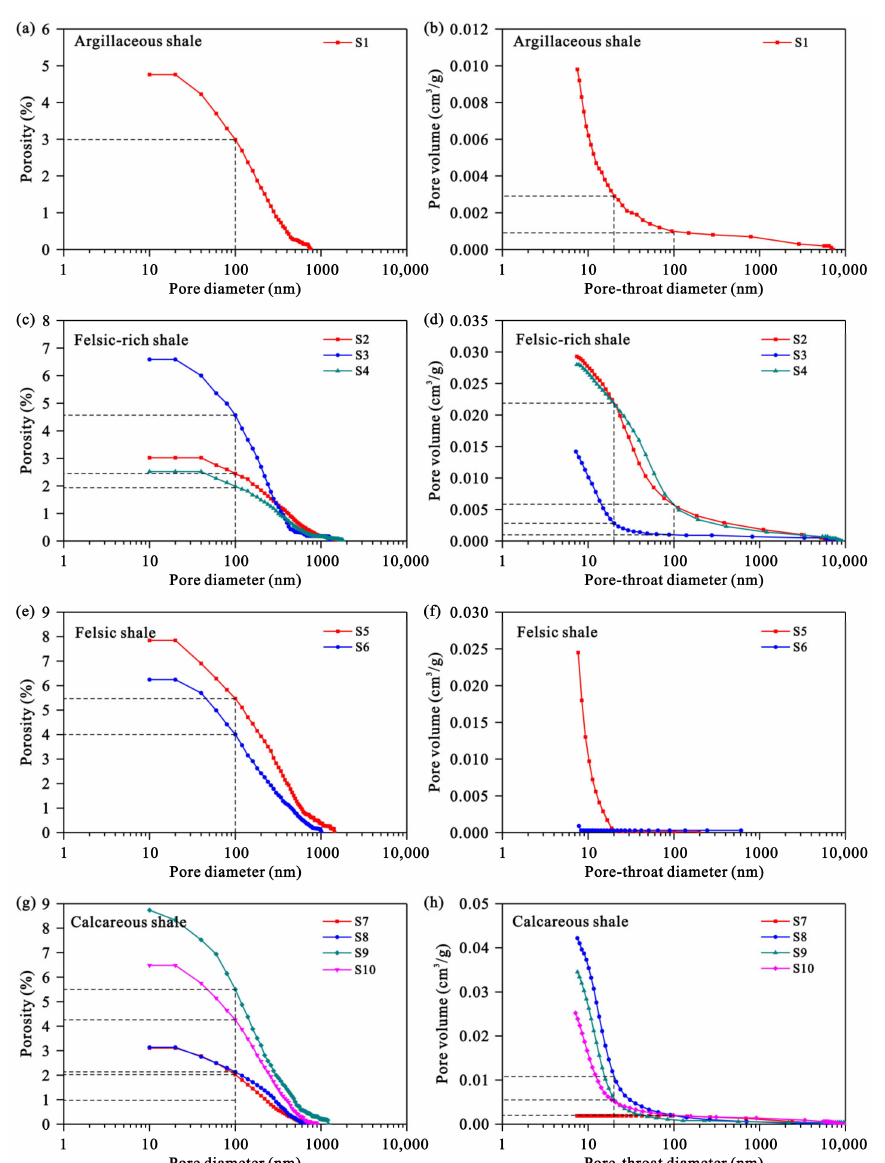
Figure 19. Pore/throat size distribution in shales: ( a ) Pore size distribution of argillaceous shales; ( b ) Pore throat distribution of argillaceous shales; ( c ) Pore size distribution of felsic-rich shales; ( d ) Pore throat distribution of felsic-rich shales; ( e ) Pore size distribution of felsic shales; ( f ) Pore throat distribution of felsic shales; ( g ) Pore size distribution of calcareous shales; ( h ) Pore throat distribution of calcareous